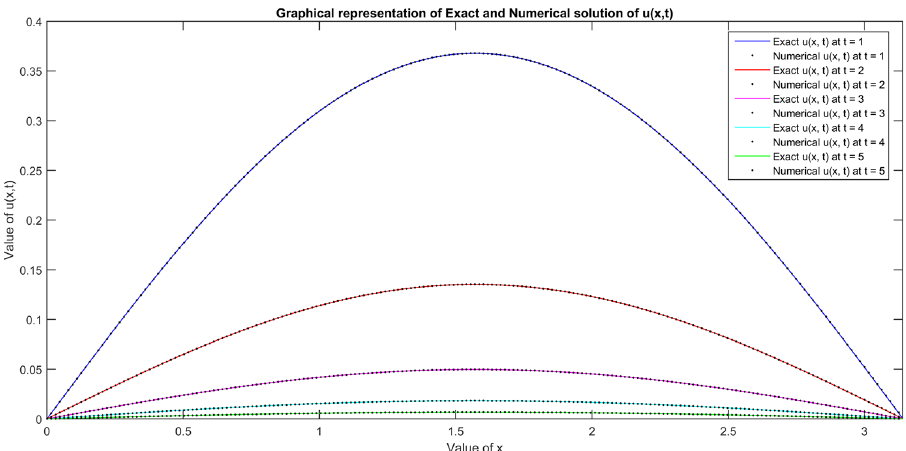
Figure 1: Graphical plot for ( ) u x t , at t = 1, 2, 3, 4, and 5 for N = 201, α = 10, β = 5, t Δ = 0.0001, = τ 0.5 using Method I regarding Example 1.